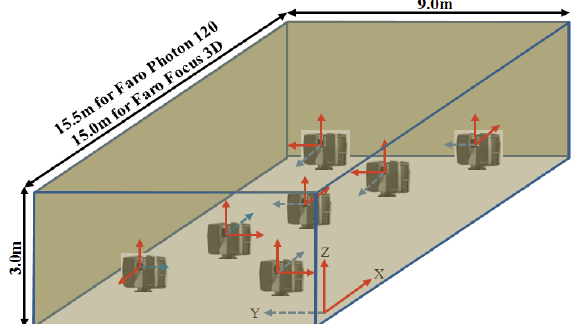
Figure 3. Scanner locations during self-calibration.